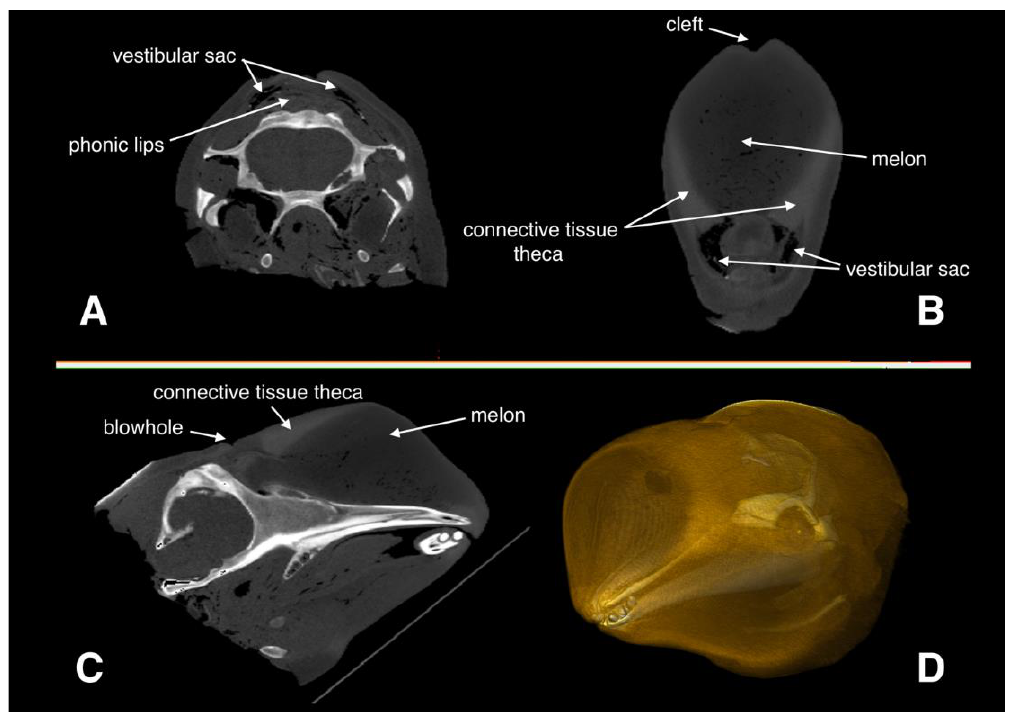
Figure 2. CT scan of the Risso’s dolphin’s head. ( A ) Cross plane, ( B ) frontal plane, and ( C ) sagittal plane of the head. The gray level represents the different HU values. ( D ) 3D reconstruction of the head. The yellow transparent parts are soft tissue.